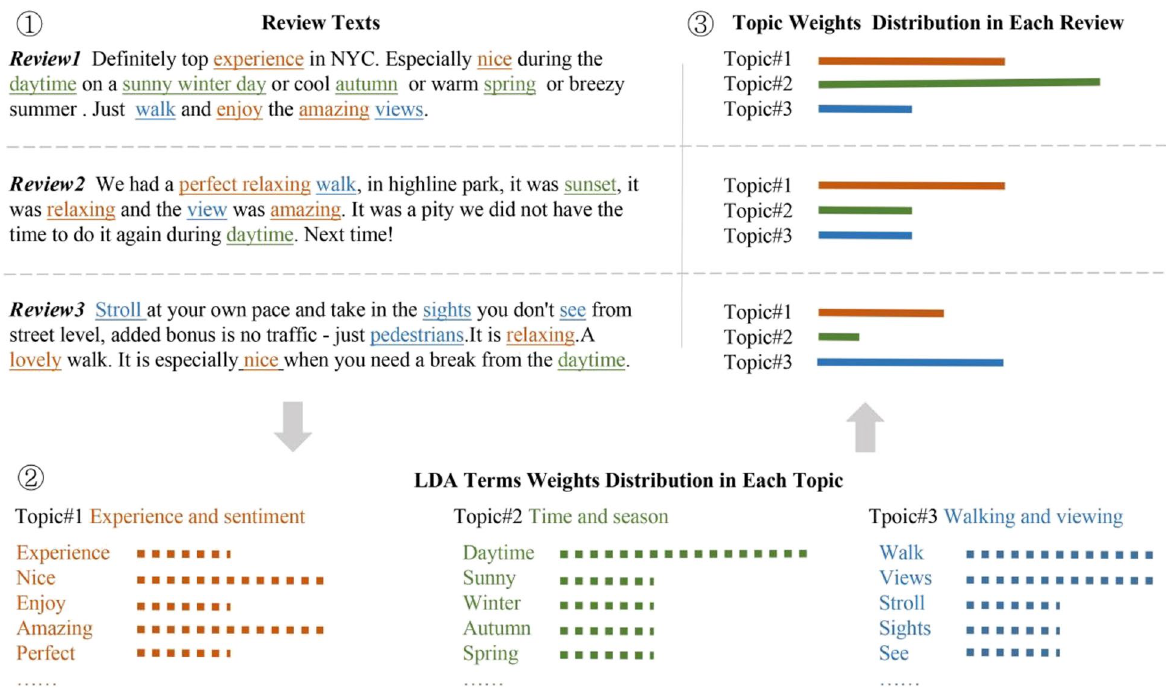
Fig. 3 LDA topic modelling illustration